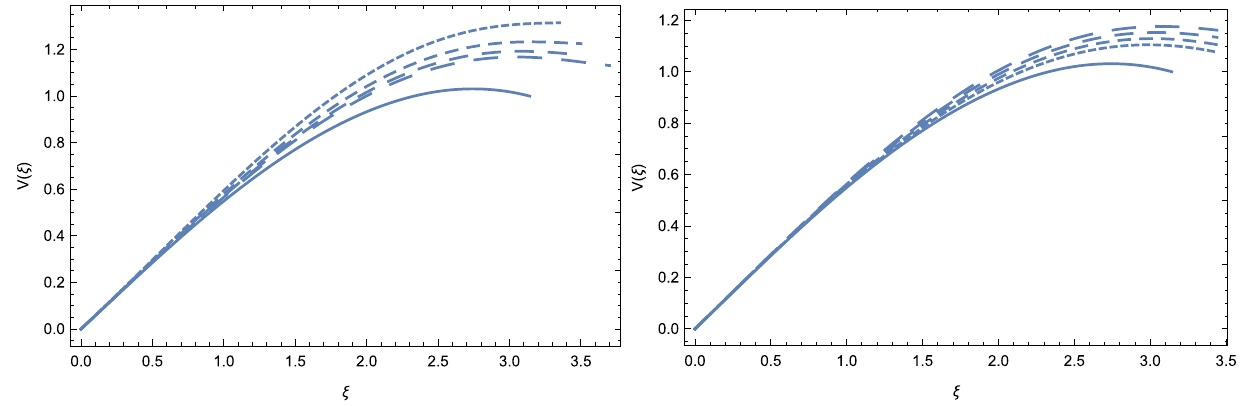
while θ = 0 . 001 (dotted curve), θ = 0 . 002 (short dashed curve), θ = 0 . 003 (dashed curve), and θ = 0 . 004 (long dashed curve), respec- tively. In both Figures the solid curve corresponds to the ideal non- rotating condensate dark matter halo, with θ = 0, γ = 0, (cid:2) = 0, ρ = 0, and σ = bc